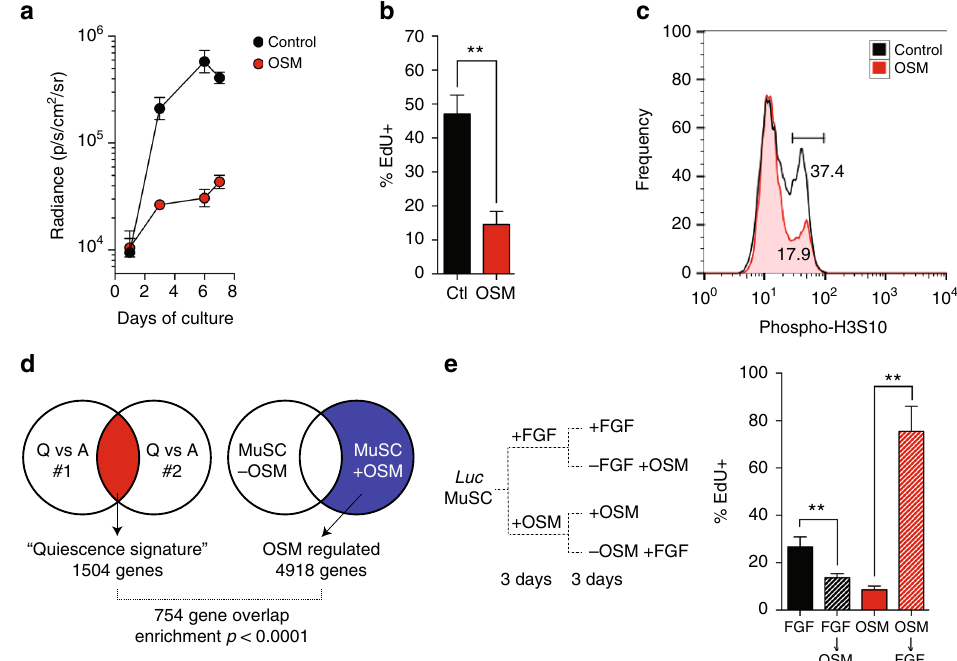
Fig. 2 OSM induces reversible cell cycle exit and a molecular signature of quiescence. a FACS-sorted muscle stem cells puri fi ed from luciferase transgenic mice were cultured for 7 days at 2500 sorted counts per well (~31 cells/mm 2 ) in the presence (closed circle) or absence (open circles) of OSM, as well as low dose FGF (0.5 ng/ml). Serial in vitro BLI was performed at the indicated timepoints. Mean±SD is shown, n = 4 replicates. b FACS-sorted MuSC cultured for 6 days as in (A) were pulsed with EdU for the last 12 h of culture. Mean±SD is shown, n = 4 replicates. c Induction of cell cycle exit in myoblasts in response to OSM. Primary myoblasts were cultured for 3 days in growth medium with (red) out without (gray) added OSM. Cells were fi xed, intracellular staining performed for mitotic H3S10 phosphorylation, and analyzed by fl ow cytometry. d Diagram demonstrating overlap between a bioinformatically-derived gene expression “ quiescence signature ” for satellite cells, and genes regulated during OSM-treatment of muscle stem cells in vitro. OSM regulation data was derived mean of 2 biological replicates. e Schematic of switch experiment to demonstrate reversibility of OSM-induced cell cycle exit (left). FACS-sorted MuSC were cultured for 6 days under the indicated conditions, and then pulsed with EdU for the fi nal 12 h of culture (right). Mean±SD is shown, n = 4 replicates; greater than 300 cells were counted per